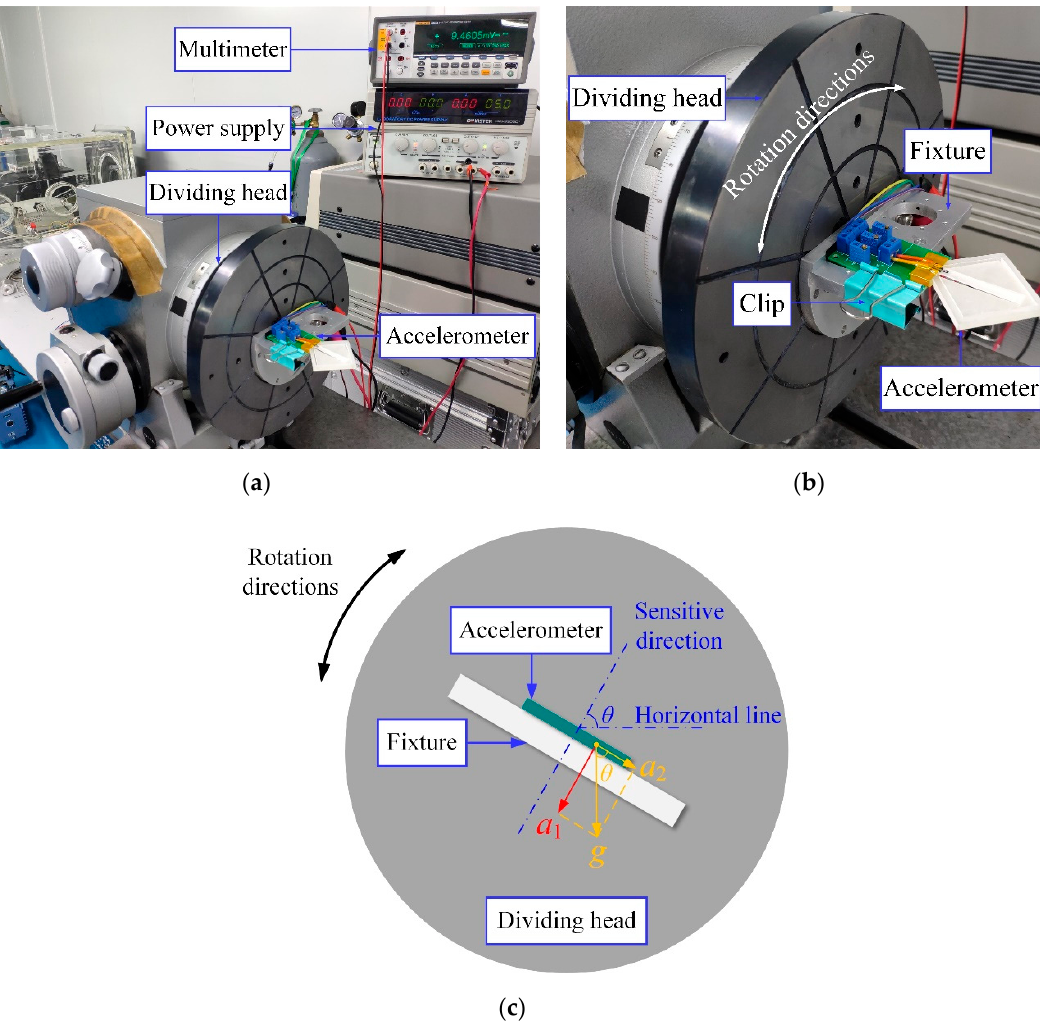
Figure 13. ( a ) The experimental setup for the tumbling experiments. ( b ) The details of the precise dividing head with the accelerometer on it. ( c ) The schematic diagram of the tumbling experiments.